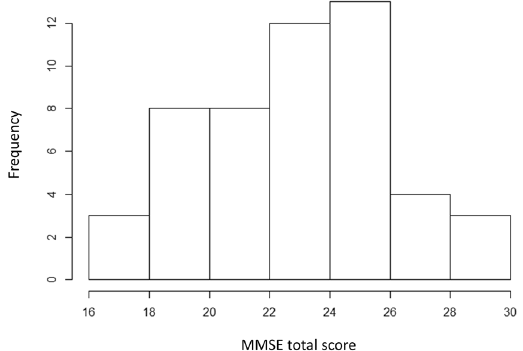
Figure 2. Histogram of Mini Mental State Examination (MMSE) total scores. The MMSE total score was 23.3 ± 3.2 (range, 16.0–29.0) (mean ± standard deviation).